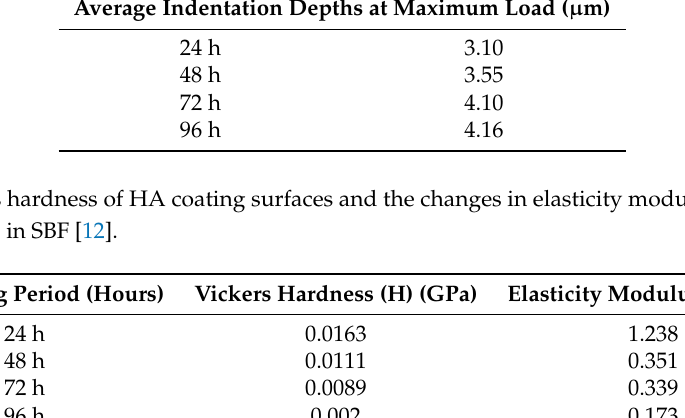
Table 5. Average Indentation Depths of HA coating surfaces under 2 mN load applied in nano-indentation device [12].